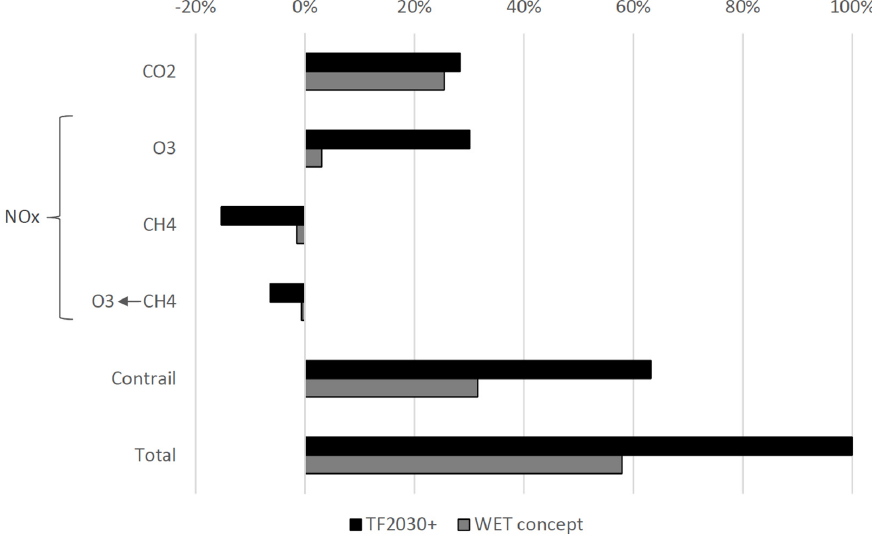
Figure 7. Absolute Pulse Global Warming Potential (APGWP) over one hundred years of the WET concept relative to TF2030+ at same technology level. We assume 10% fuel burn reduction, 50% contrail reduction, and 90% NO x reduction. For simplicity, only the cruise segment at 35,000 ft is considered. Concerning the climate impact, scientific uncertainties are omitted.